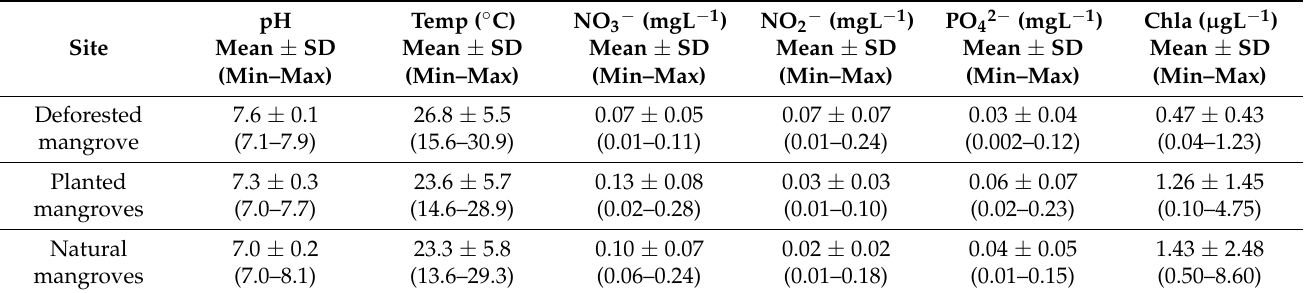
Table 1. The values of physicochemical